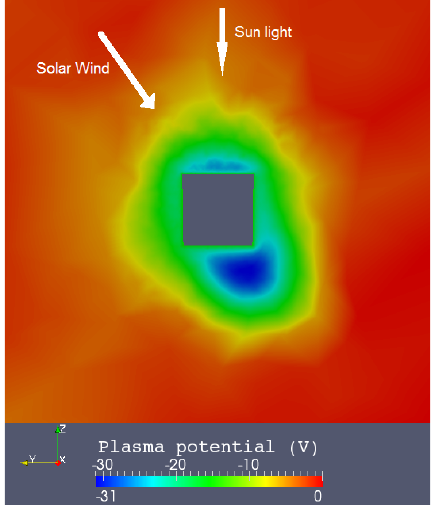
Fig. 16. Simulation S5: map of the final plasma potential in a X = 0